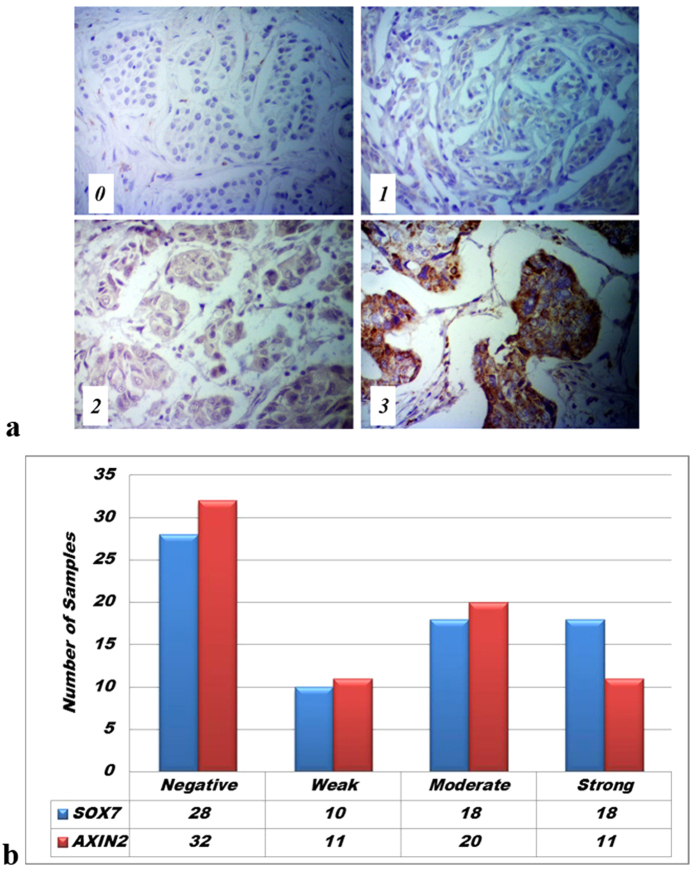
Staining intensity grades for SOX7.(a) Examples of 0, 1+, 2+, or 3+ nuclear and partially cytoplasmic staining SOX7 IHC in breast cancer cells. (b) Statistical graph was shown SOX7 and AXIN2 after imunohistochemical stains, from left to right, negative (a), weak (b), moderate(c) and strong stain (d), over half of samples performed negative or weak expression level in breast cancer. The two genes had a similar expression trend.